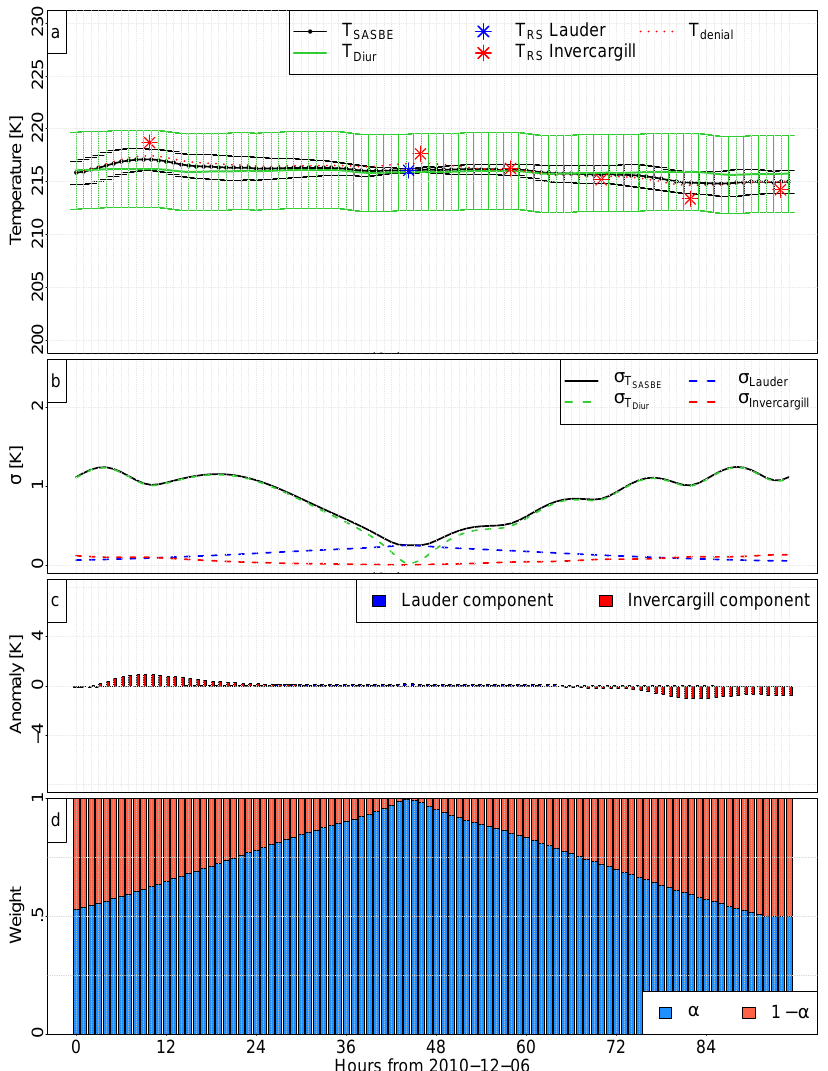
Figure 6. As in Fig. 4, but at